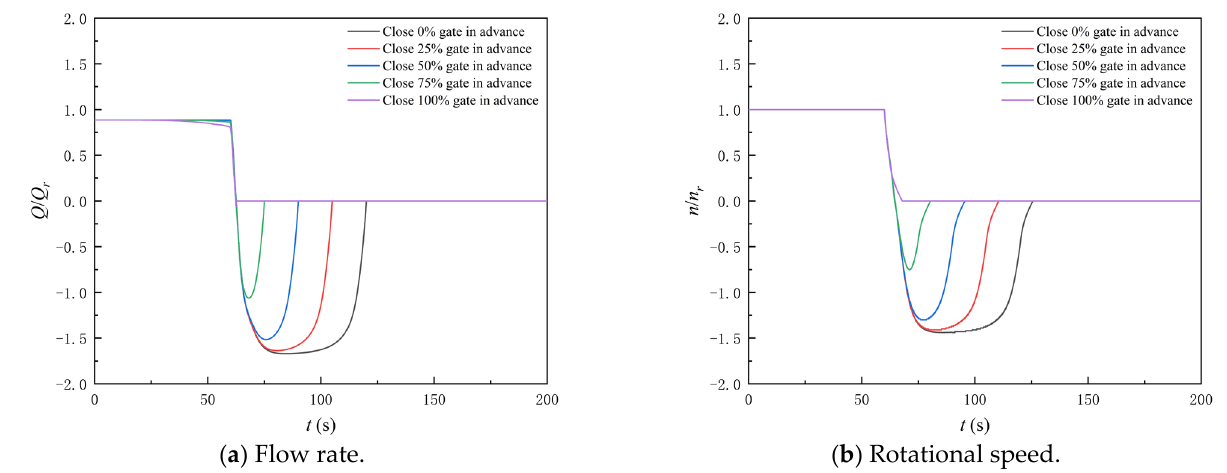
Figure 16. Variation law of the flow and rotating speeds with time under the different gate closure schemes (TTGC: 60 s).